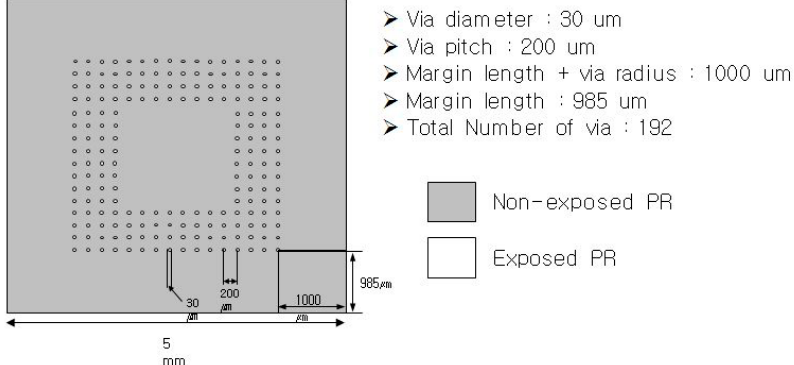
Figure 1. Position and spacing of Si via holes on a sub-cell.